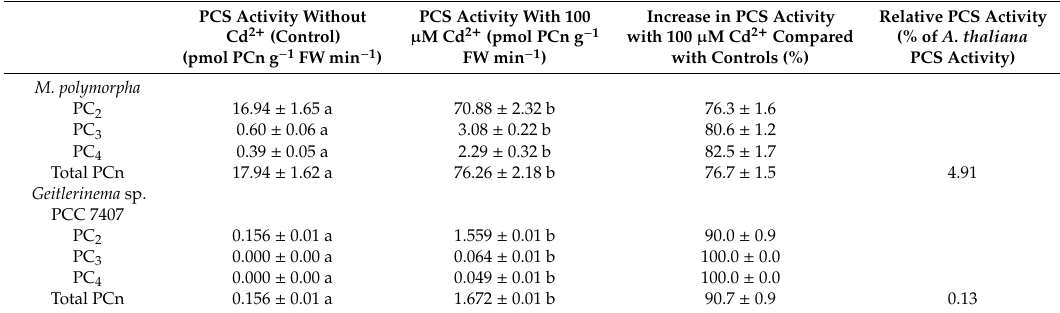
Table 1. In vitro activity assay of phytochelatin synthases (PCSs) from Marchantia polymorpha gametophytes and Geitlerinema sp. PCC 7407 cultures, either without Cd (control) or with the addition of 100 µ M Cd. The assay was carried out at 35 ◦ C for 90 min in the proper reaction bu ff er (see M&M). PCS activity (mean ± SE) is expressed as pmol PCn g − 1 FW min − 1 ; n = 5. Di ff erent letters indicate significant di ff erences between PCS activity in control and in 100 µ M Cd (Mann–Whitney test, p < 0.05). The increase (%) in PCS activity in the presence of 100 µ M Cd, compared with the respective control, is also given, by setting controls equal to 0% in enzyme activity and expressing the Cd-increased activity in %. The percentage of PCS activity relative to that of A. thaliana PCS (equal to 1187.80 ± 14.27 pmol PCn g − 1 FW min − 1 , fixed as 100%), assayed with the same Cd concentration and bu ff er conditions, is also